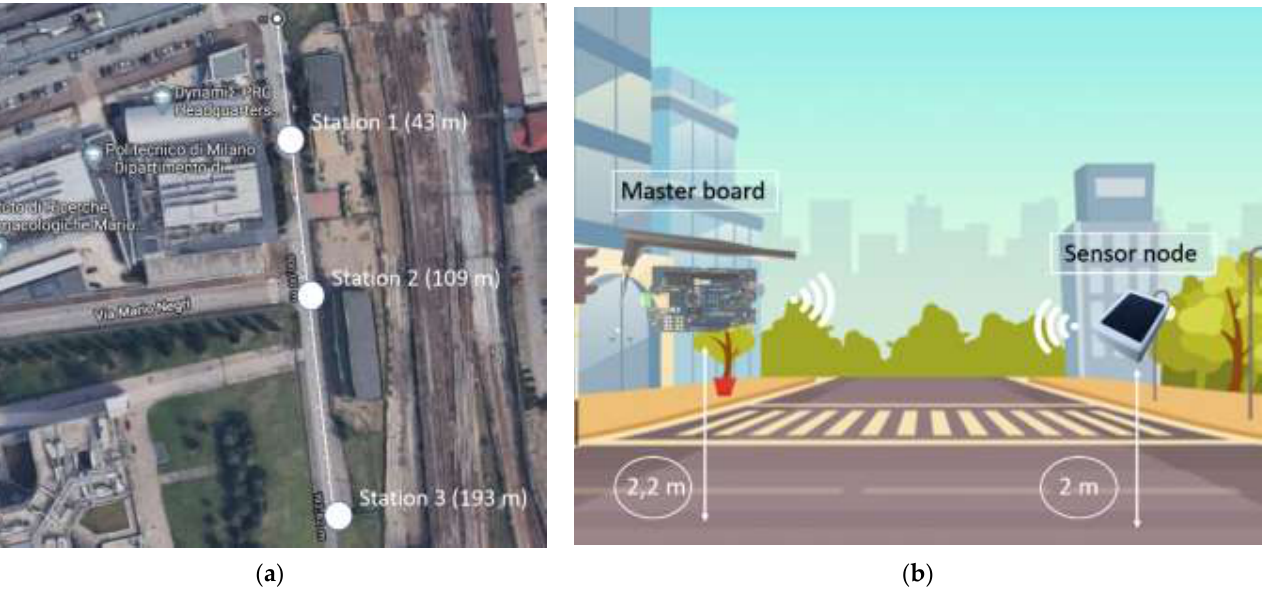
Figure 9. Communication range test in urban scenario: ( a ) Map of the test area [1] © 2020 IEEE and ( b ) positioning of master board and sensor node during the test.